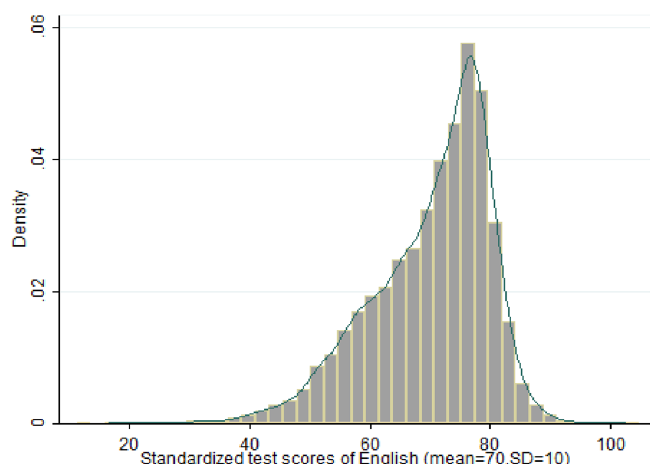
Figure 3. Distribution of English test